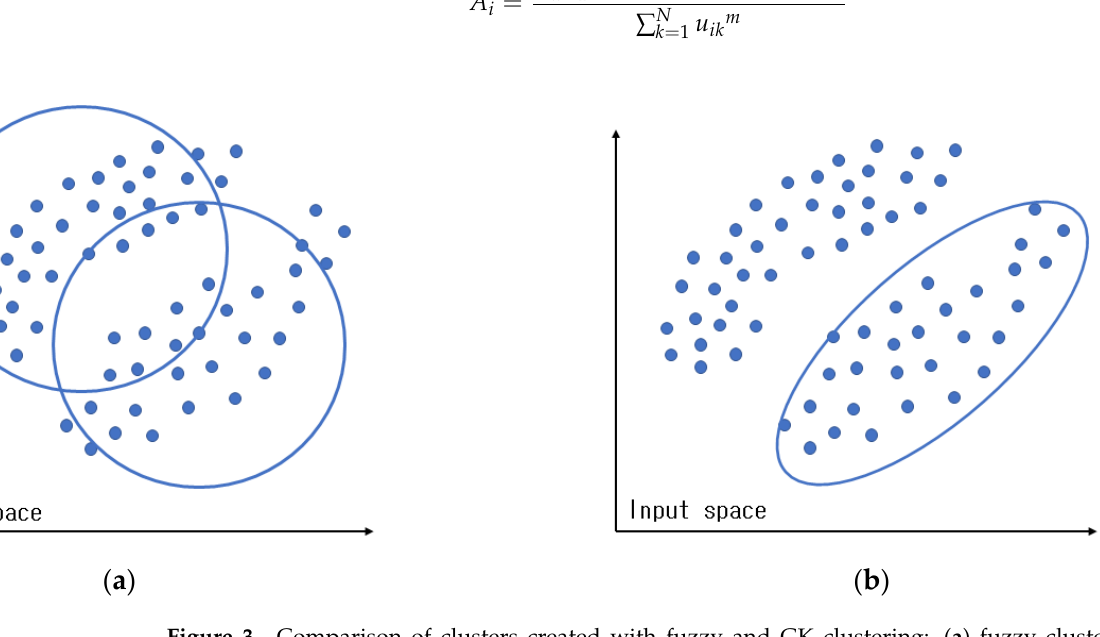
Figure 3. Comparison of clusters created with fuzzy and GK clustering: ( a ) fuzzy clustering; ( b ) GK clustering.